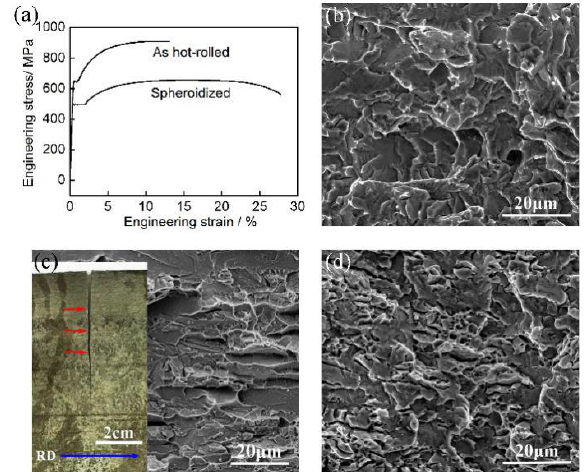
Figure 9. Tensile mechanical properties and SEM images of fracture morphology of the as hot-rolled